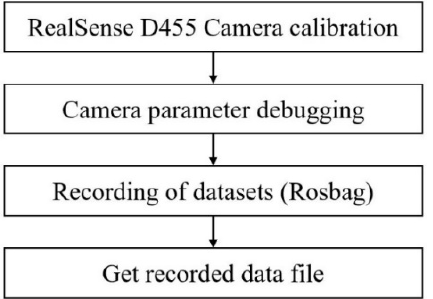
Figure 6. Data acquisition flow chart of the depth camera.